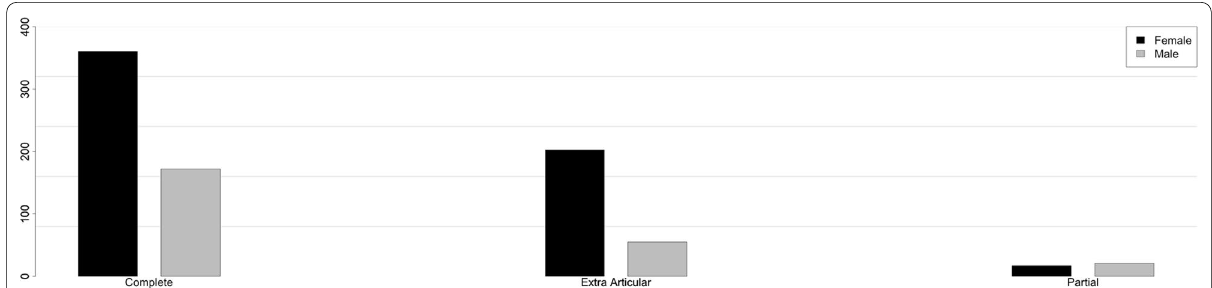
Fig. 5 Distribution of DRFs patterns according to gender. M, male; F, female; DRFs, distal radius